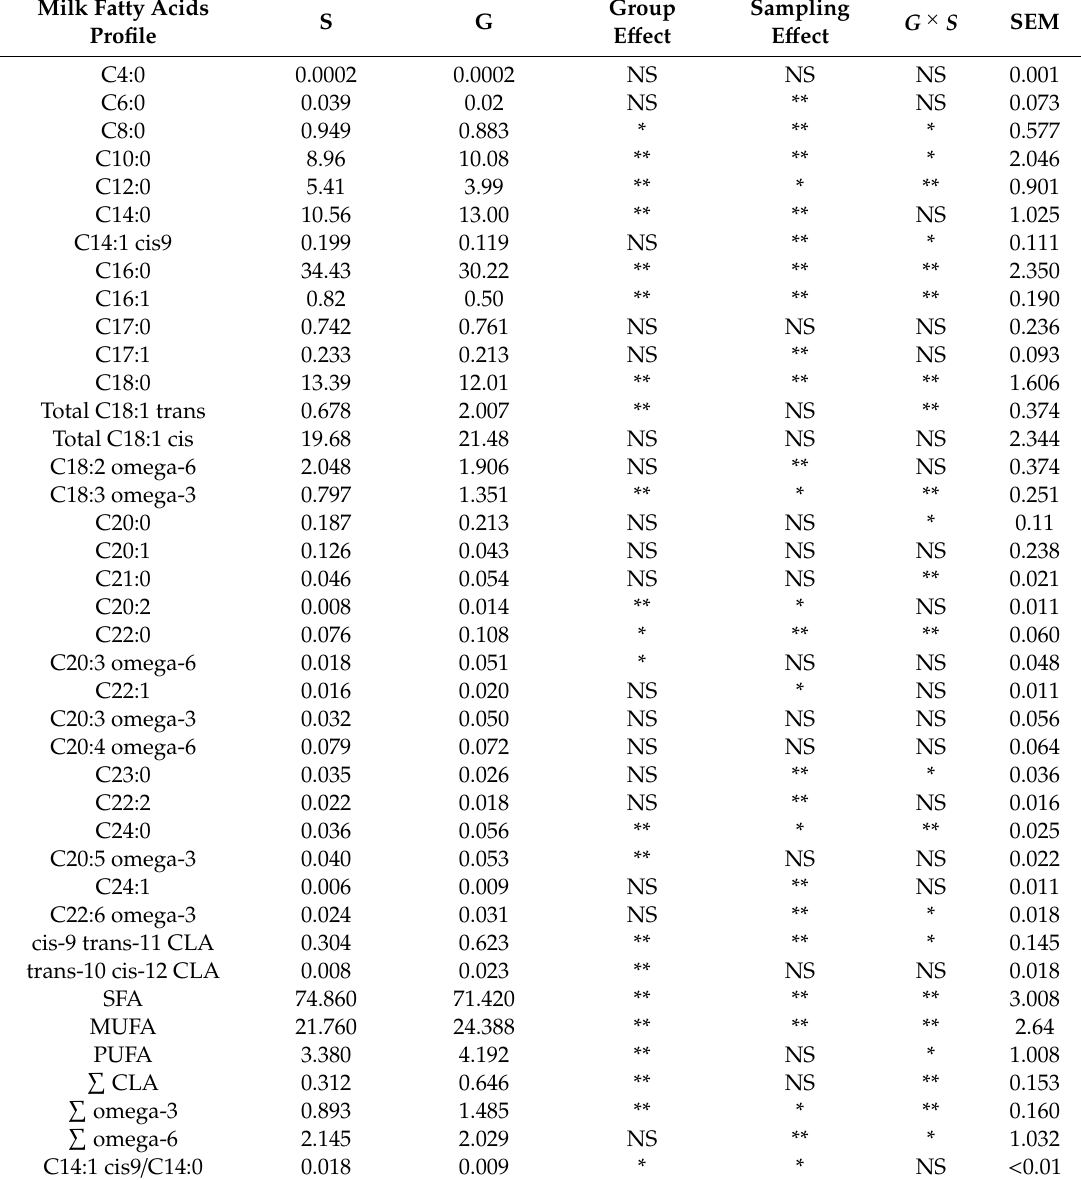
Table 3. Milk fatty acid profile (% total fatty acids).